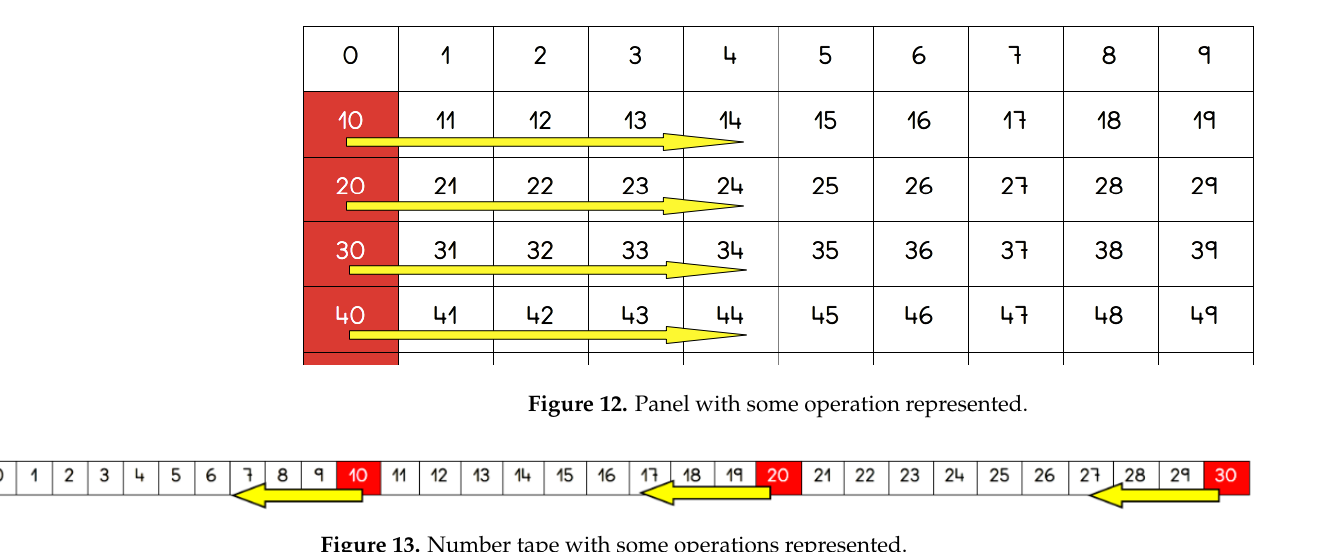
Figure 12. Panel with some operation represented. Figure 13. Number tape with some operations represented.